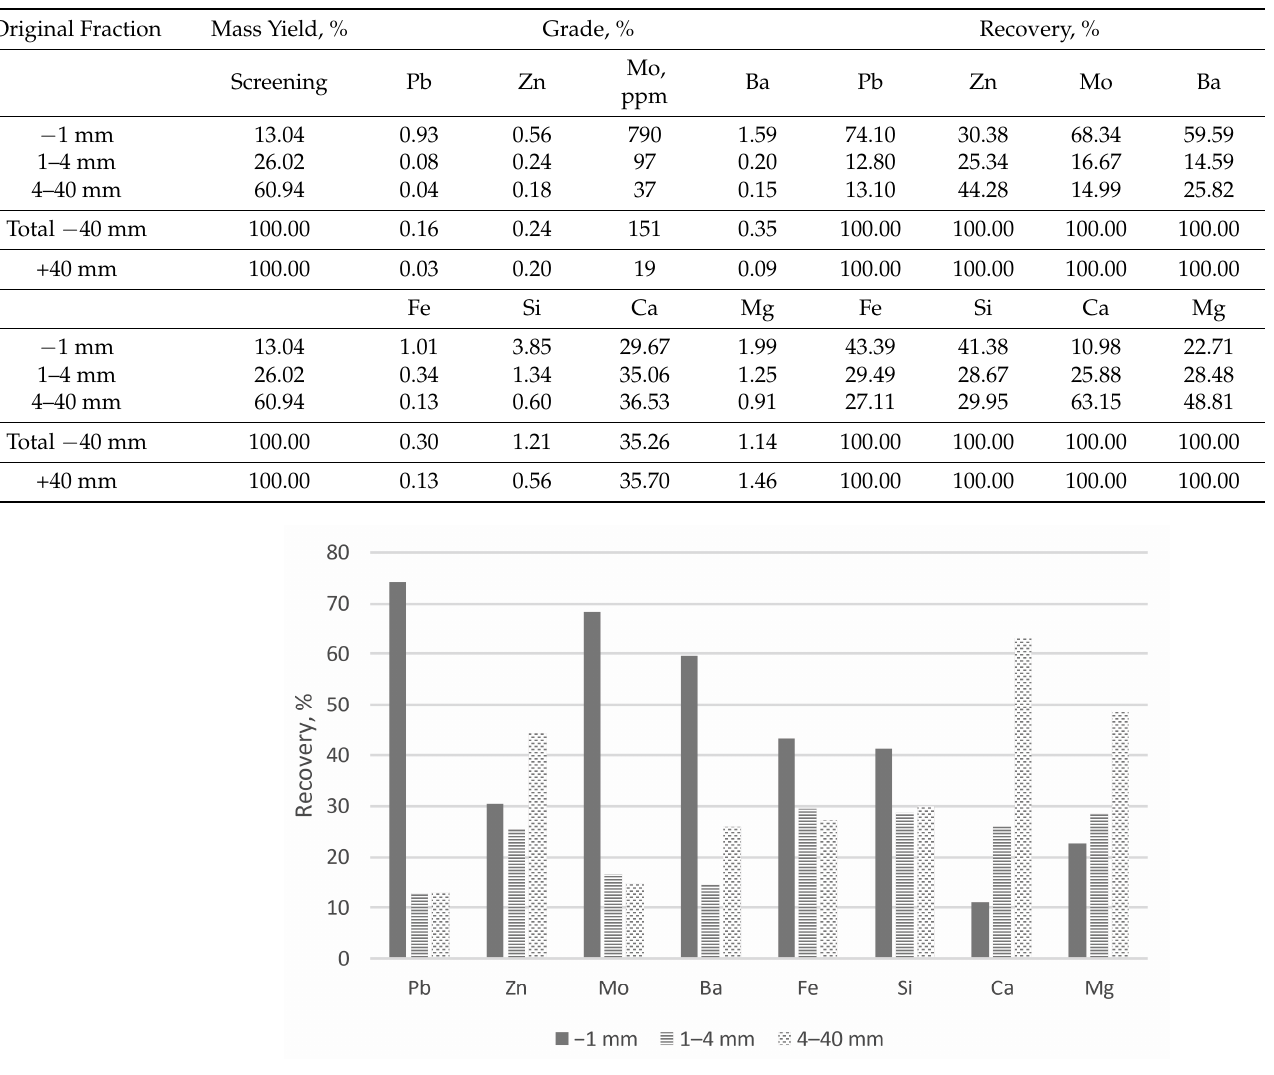
Figure 10. Distribution of selected components within the size fractions − 1 mm, 1–4 mm, and 4–40 mm for sample A1 top.